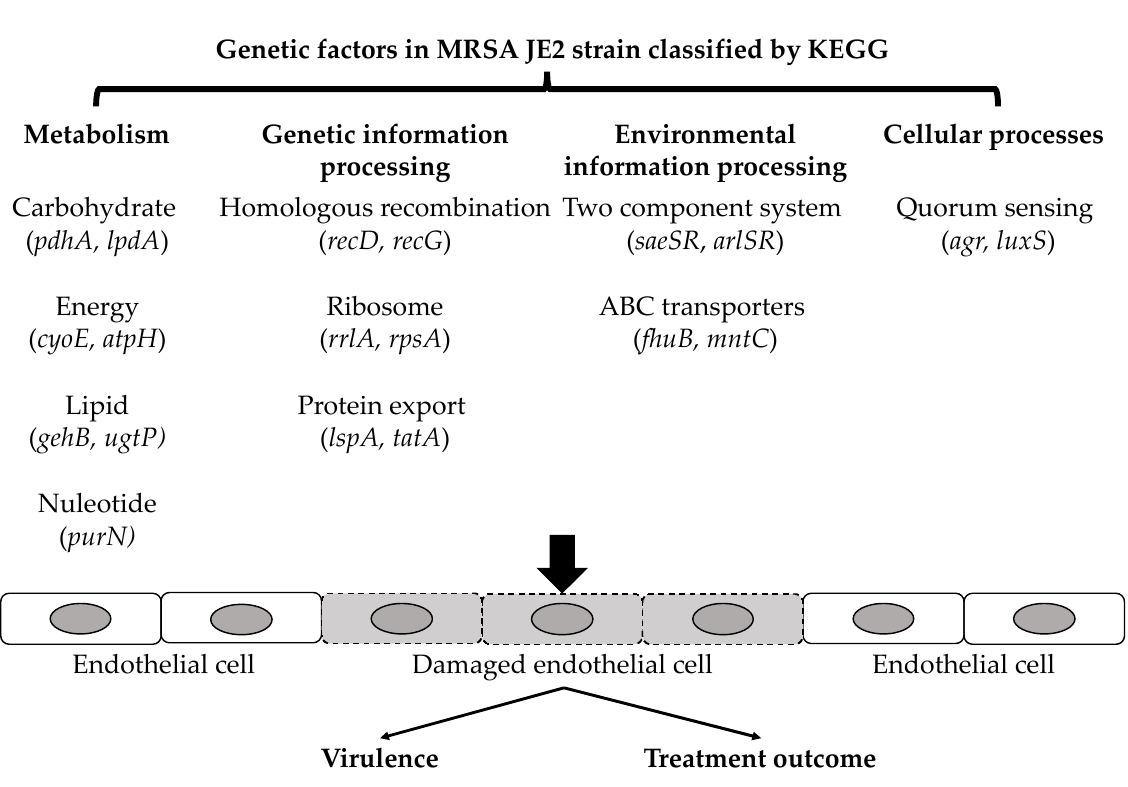
Figure 3. Genetic factors in MRSA JE2 strain contribute to the HMEC-1 damage by KEGG analysis. These factors may ultimately impact the pathogenesis and treatment outcome in MRSA endovascular infection.